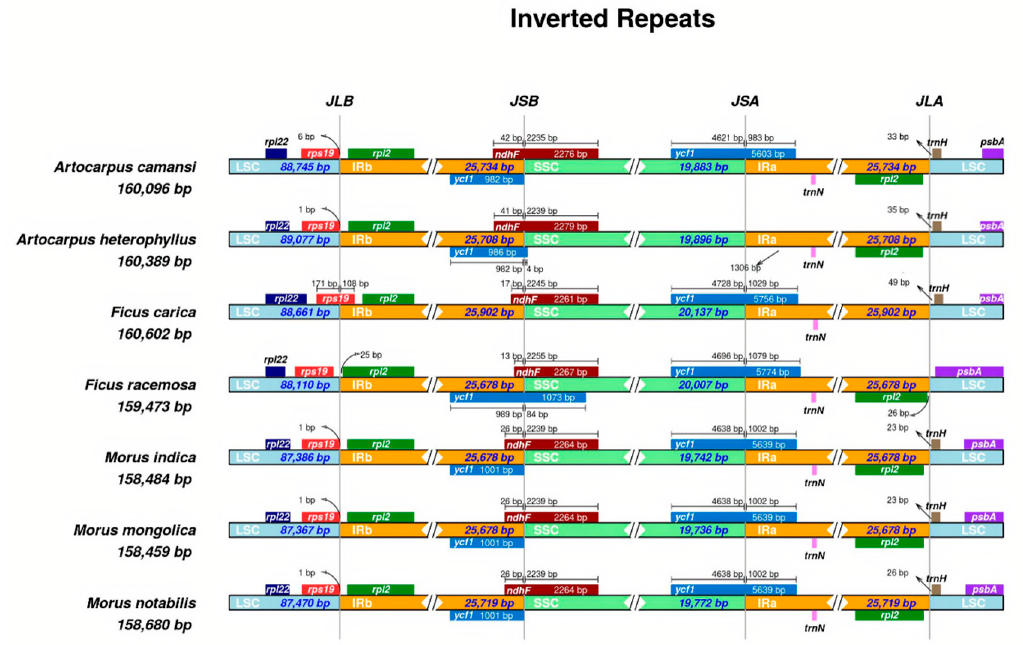
Figure 7. Comparison of the borders of the LSC (light blue), SSC (light green), and IR (orange) regions among the seven moraceous plastid genomes analyzed in the present study.